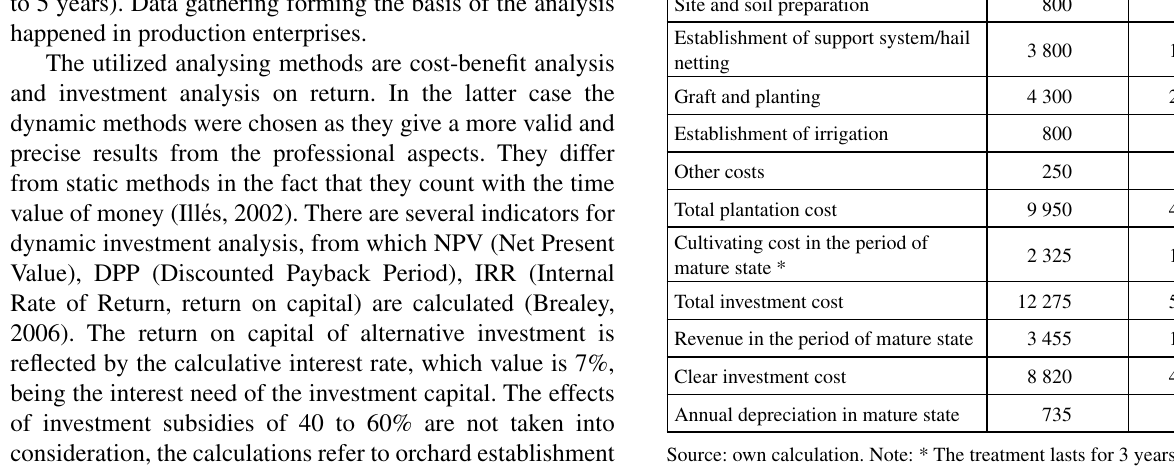
Table 2: Investment Cost of the Characterized Apple Orchards (thousand HUF/ha)